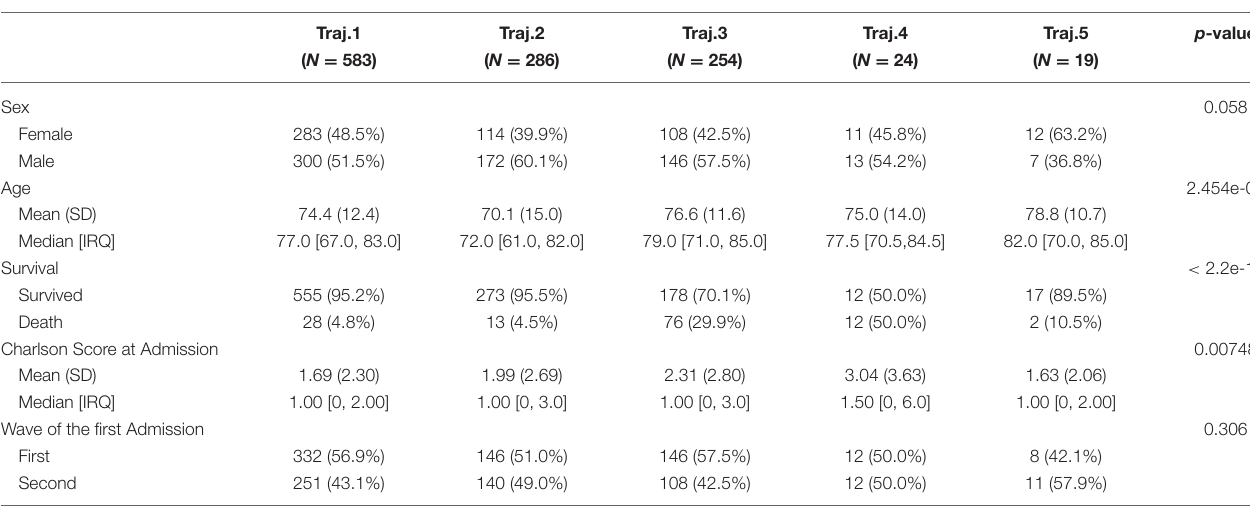
TABLE 2 | Population distribution in trajectories